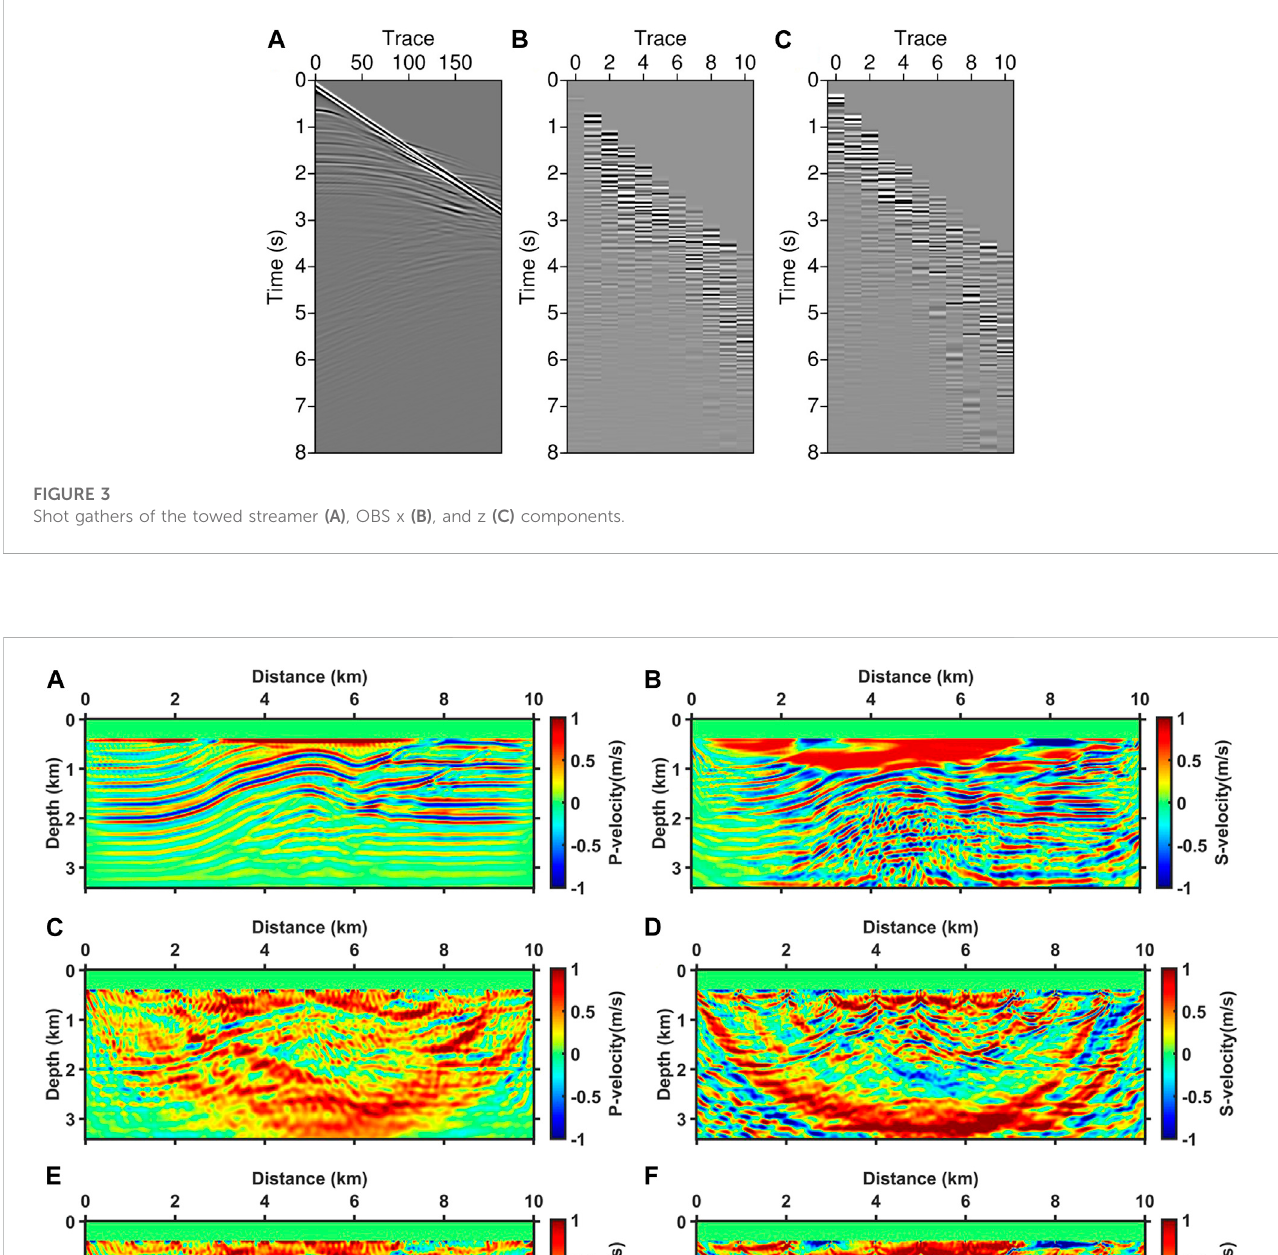
Figure 2. The experimental acquisitions followed the towed streamer and the OBS acquisition. A total of 200 streamer hydrophones were spaced 20 m apart at the seawater surface, and 11 OBS were spaced 1,000 m apart